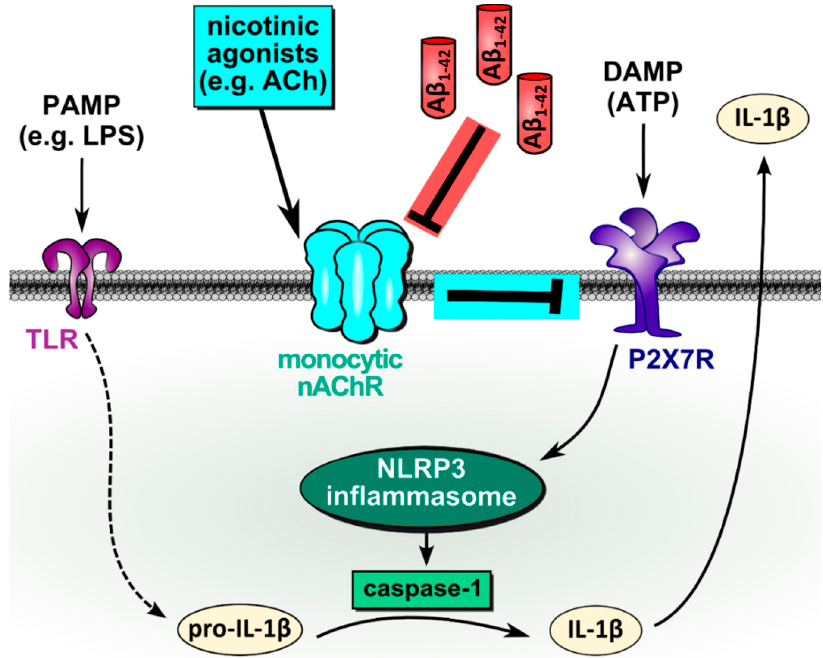
Figure 6. Schematic summary of the proposed mechanism. In LPS-primed monocytic cells, extracellular ATP, originating from dead or injured cells, binds to the ATP-sensitive P2X7R, induces NLRP3 inflammasome assembly, activation of caspase-1, cleavage of pro-IL-1 β and release of bioactive IL-1 β . This damage-associated release of IL-1 β is inhibited by the activation of monocytic nAChRs containing subunits α 9, α 7, and/or α 10. As shown previously, activation of nAChRs inhibits the ion channel function of P2X7R and, thus, ATP-induced IL-1 β release [6,7]. Our data suggest that amyloid beta (A β 1-42 ) antagonizes this inhibitory effect and enables monocytic release of IL-1 β in the presence of nicotinic agonists. ACh, acetylcholine; ATP, adenosine triphosphate; DAMP, danger-associated molecular pattern; IL-1 β , interleukin-1 β ; LPS, lipopolysaccharide; nAChR, nicotinic acetylcholine receptor; NLRP3, NACHT, LRR, and PYD domains-containing protein 3; P2X7R, P2X7 receptor; PAMP, pathogen-associated molecular pattern; TLR, Toll-like receptors.